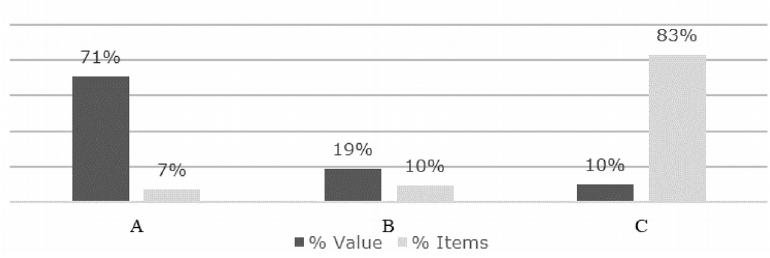
Figure 3. Inventory categorization